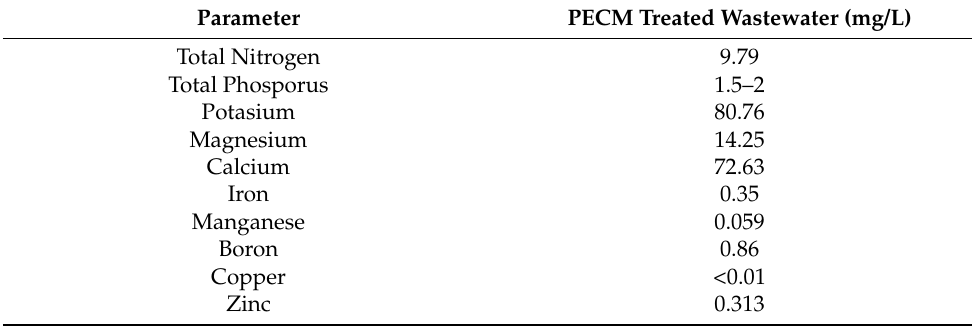
Figure 3. Illustration of the setup of the hydroponic system (Miracle Home Pot). Table 3. pH and EC measurement results of treated